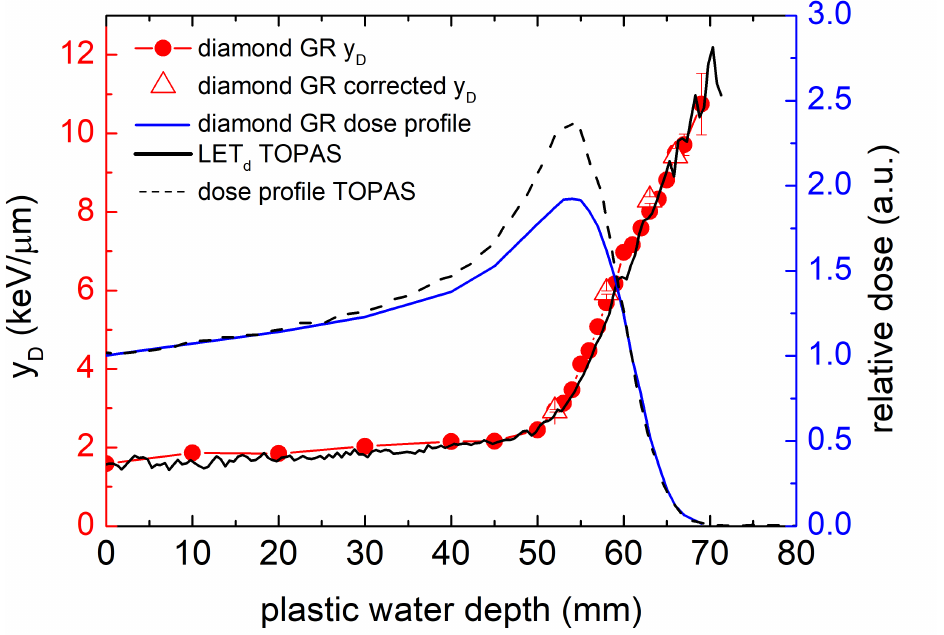
Figure 8. y along the dose profile measured with a diamond GR microdosimeter compared with D dose profile and LET d from TOPAS